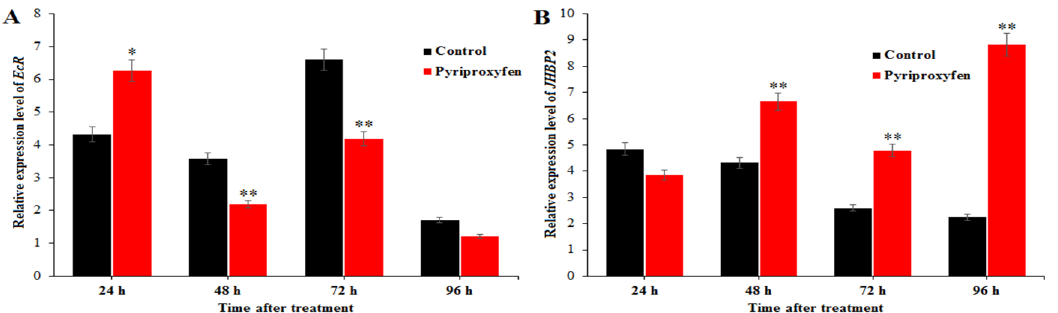
Figure 6. The e ff ect of pyriproxyfen exposure on the expression of genes related to ovarian development: ( a ) EcR and ( b ) JHBP2 . The black histogram represents the control group, and the red histogram represents the treatment group. The x -axis represents the time after pyriproxyfen exposure, and the y -axis represents the relative expression level of genes. The results are shown as the mean ± SE. Asterisks denote significant di ff erences between treatments and controls, as indicated by * p ≤ 0.05 and ** p ≤ 0.01.